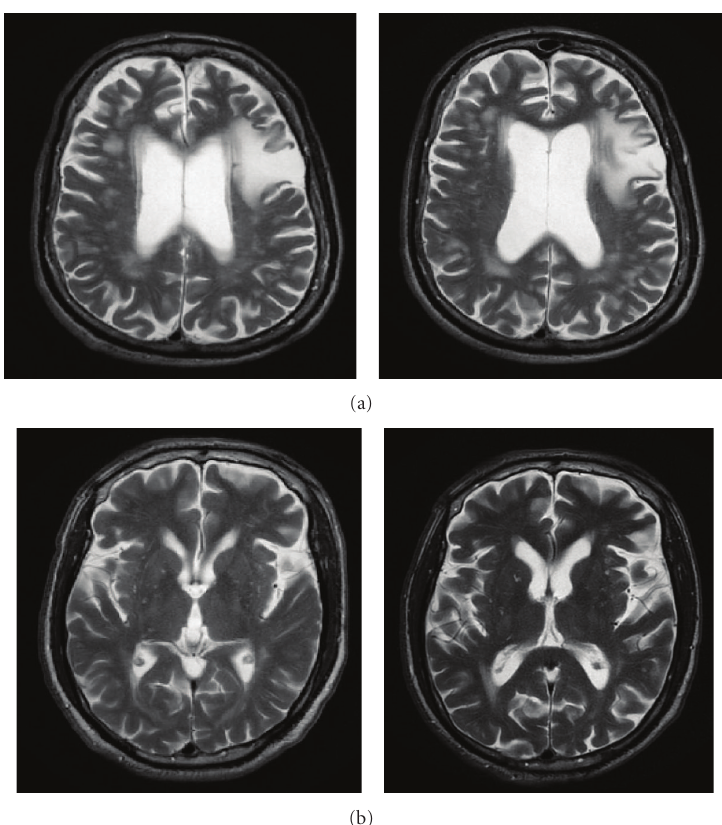
Figure 4: Shows T2 FLAIR axial images. (a) Depicts bilateral asymmetric multifocal hyperintensities involving pontine base periventricular and deep white matter suggestive of small-vessel ischemia. Di ff use brain atrophy is also seen with mineralization below globus pallidus and substantia nigra indicative of PD. There is no significant di ff erence noted between the baseline and follow-up MRI. (b) Depicts moderate brain atrophy with bilateral putaminal rim sign seen. Small-vessel ischemic changes are seen in the bilateral periventricular and deep white matter. Mineralization of bilateral lentiform nuclei, dentate nuclei, and substantia nigra visualized is suggestive of MSA-P or PD plus synd- rome. There was no significant di ff erence noted between the baseline and follow-up